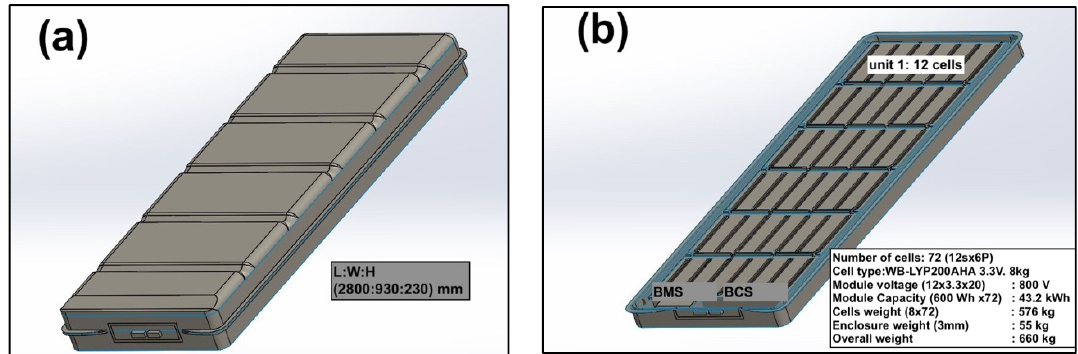
Figure 1. CAD concept of electric car power module ( a ) scalability of the module, ( b ) Electric detail of the internal parts in the power module.